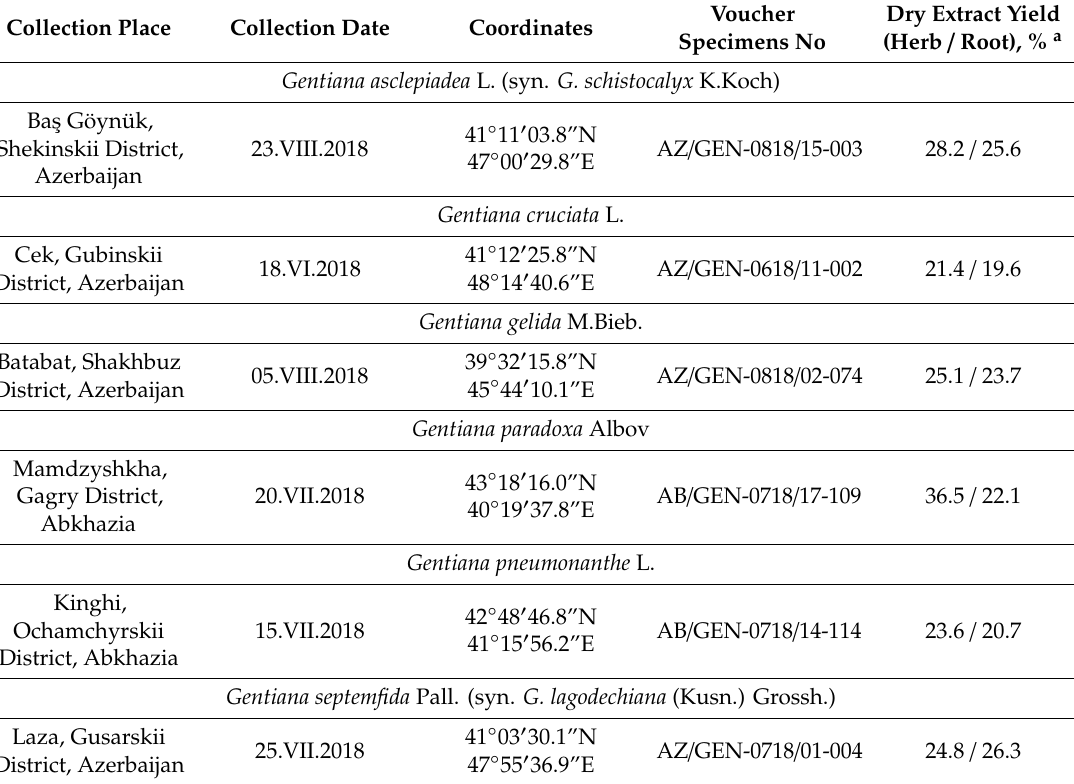
Table 4. Detailed information of gentiana